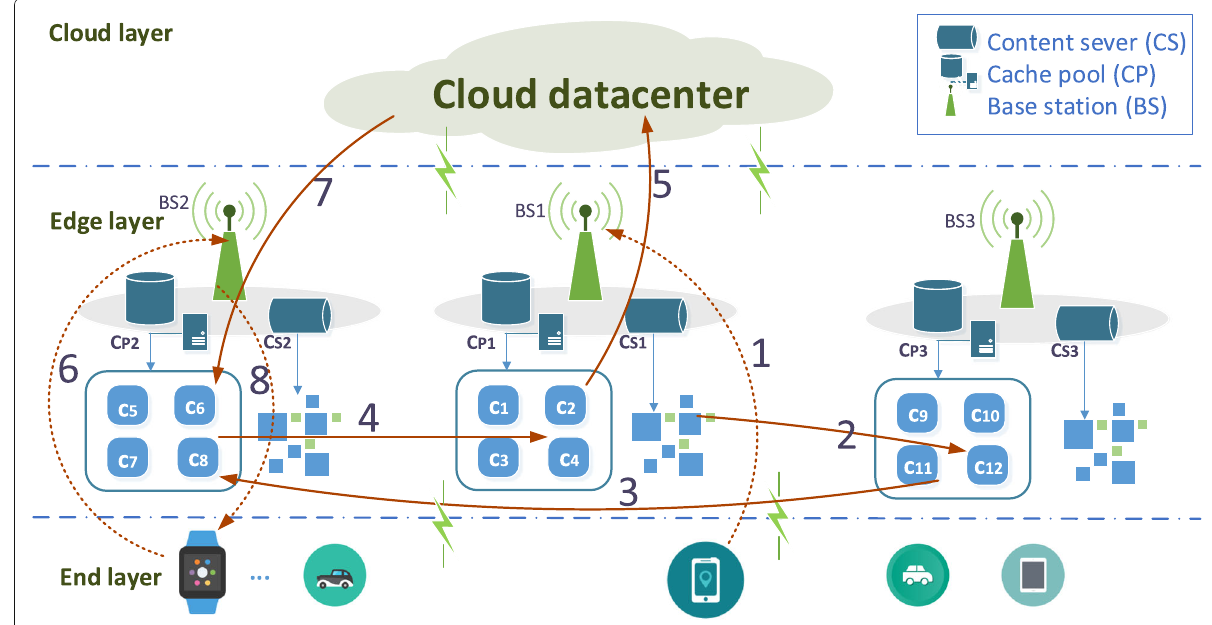
Fig. 1 Edge content update process. The detailed process is as follows: (1) a mobile user uploads a content such as c 14 to C S 1 through BS 1; (2) C S 1 copies a copy of c 14 and migrates it to C P 3 ; (3) C P 3 migrates c 14 to C P 2 ; (4) C P 2 migrates c 14 to C P 1 ; (5) C P 1 uploads c 14 to the cloud data center; (6) other mobile users request c 14 from C P 2 through BS 2; (7) the cloud data center delivers c 14 to C P 2 ; (8) C P 2 provides c 14 service to mobile